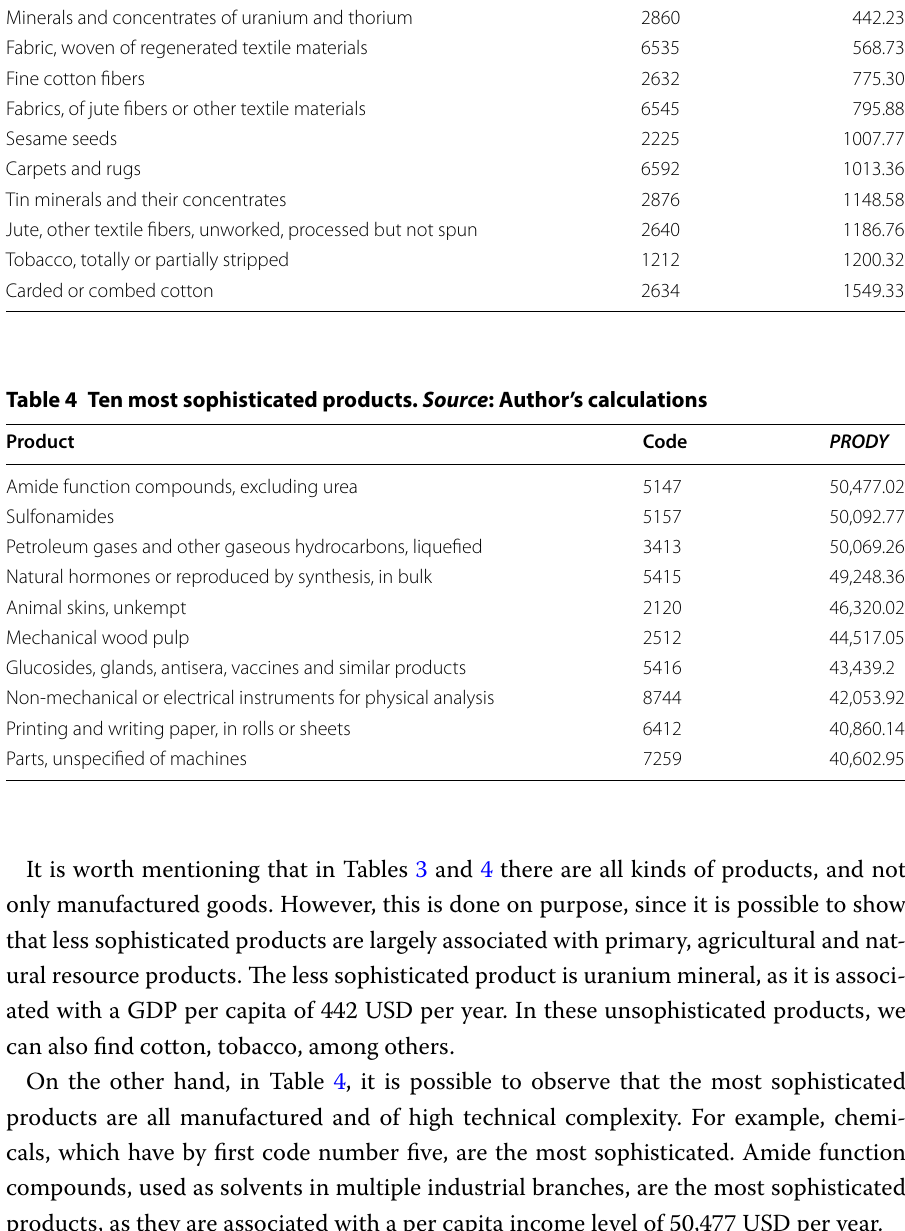
Table 3 Ten less sophisticated products. Source : Author’s calculations Product